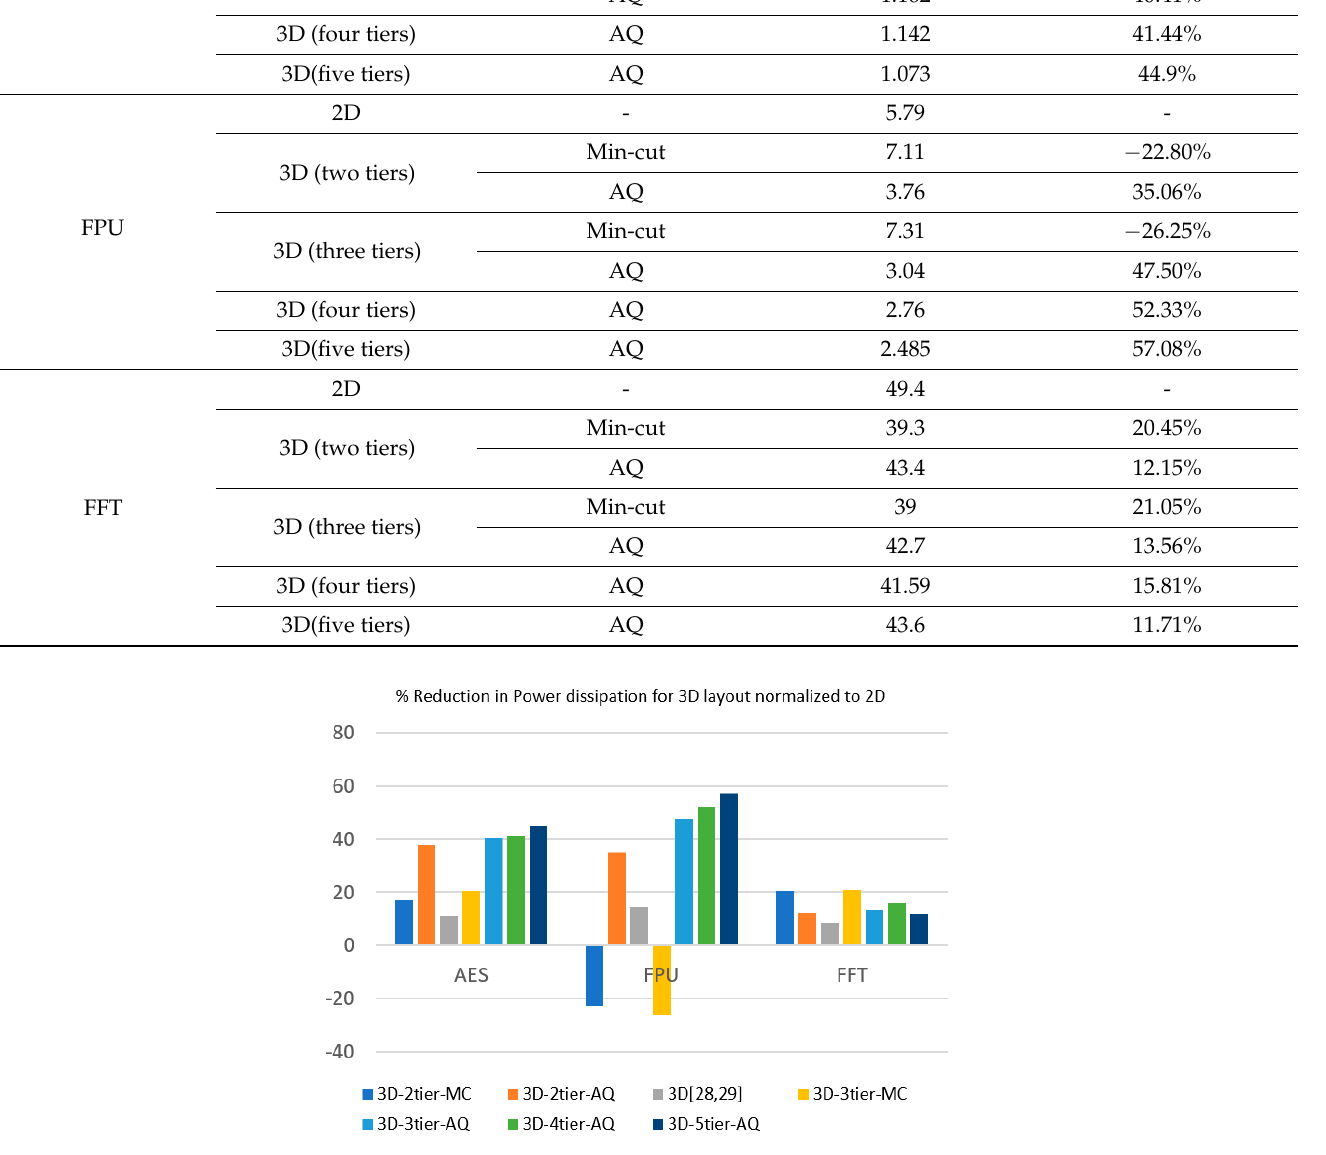
Figure 10. Reduction in power dissipation for different 3D layouts normalized to the 2D values.